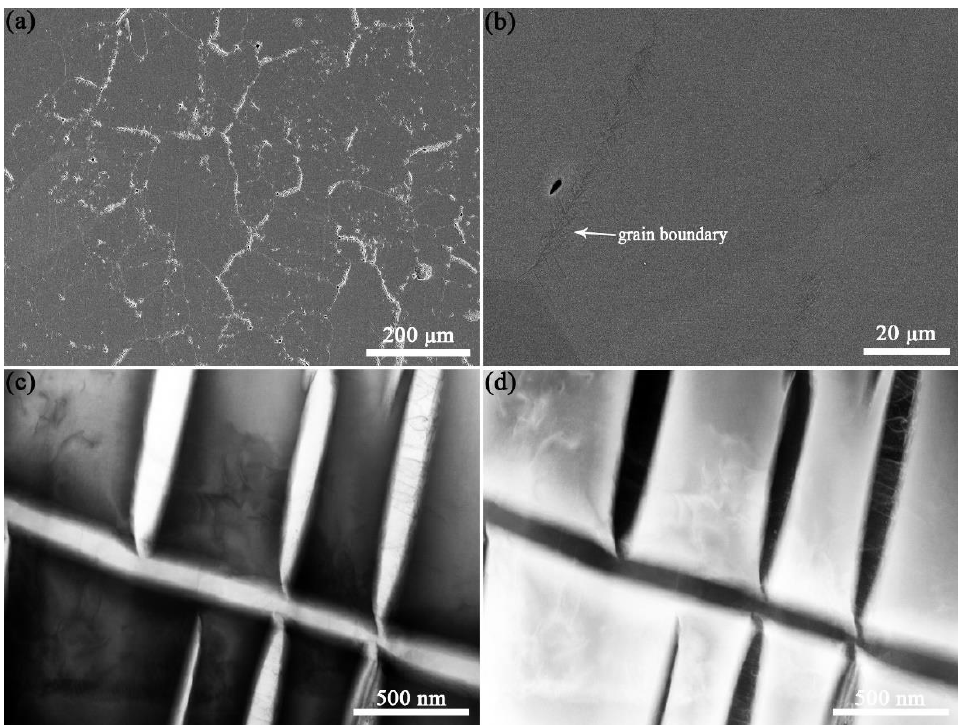
Figure 9. SEM image ( a ), BSE image ( b ), Bright-Field STEM image ( c ) and High-Angle Annular Dark Field image ( d ) of the cross-section of the sample. The BSE image ( b ) and High-Angle Annular Dark Field image ( d ) indicates that the composition of precipitates is different from that of matrix.